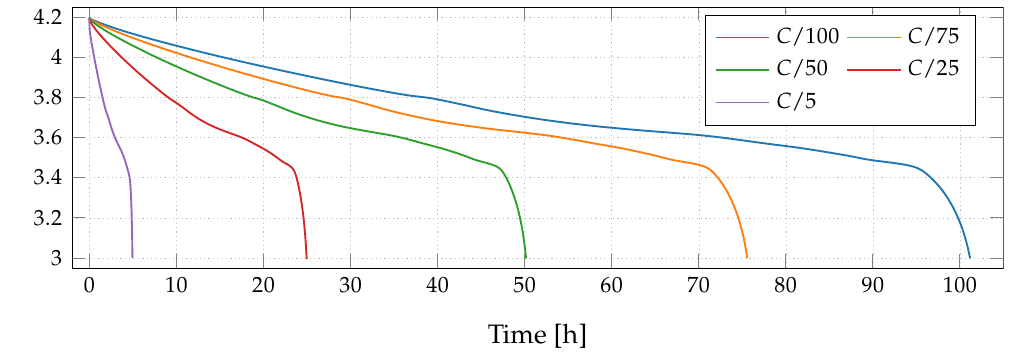
Figure 3. Terminal voltage measured during the continuous discharge with different